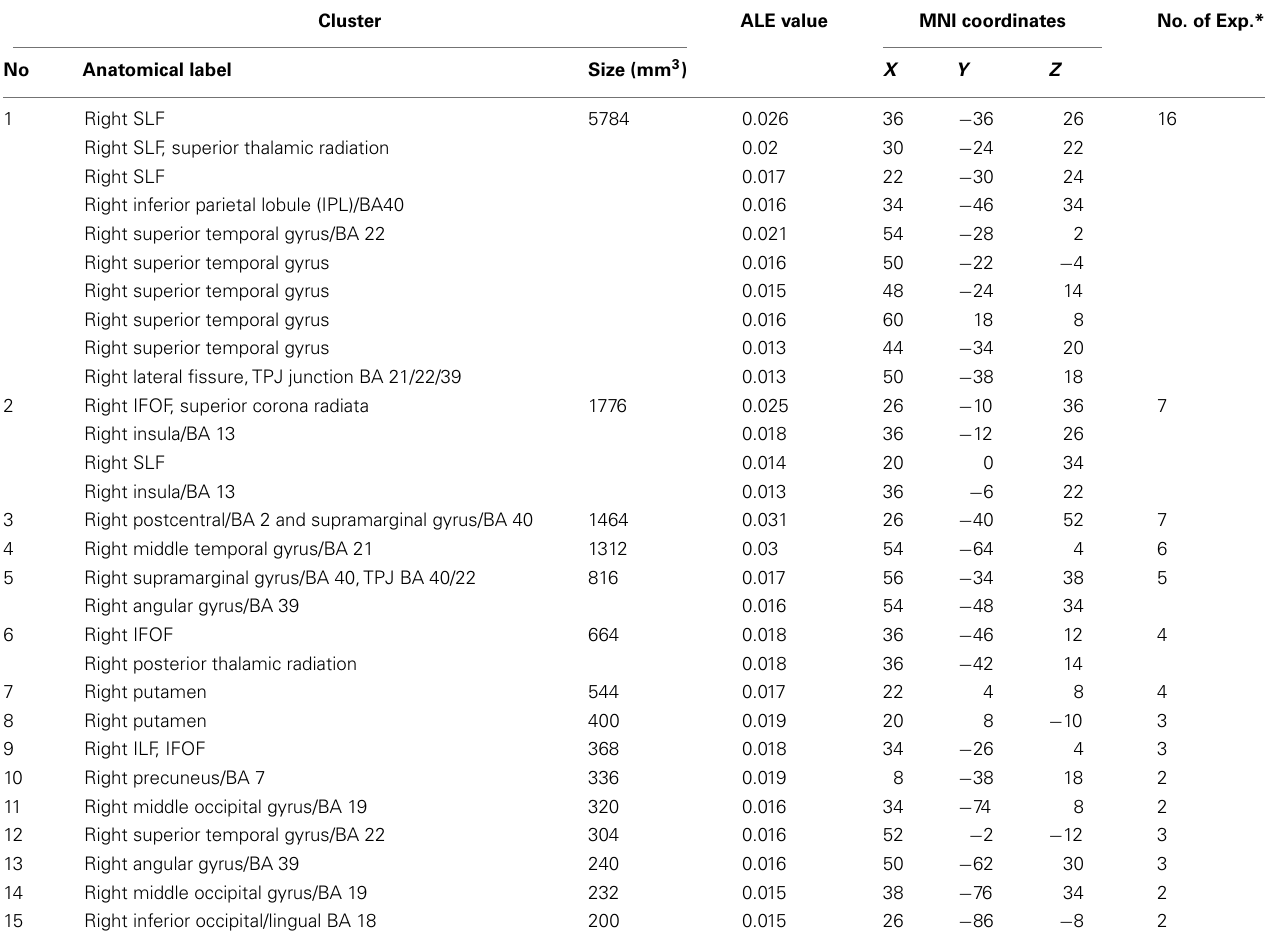
Table 2 | SignificantALE clusters and corresponding MNI coordinates identified inAnalysis